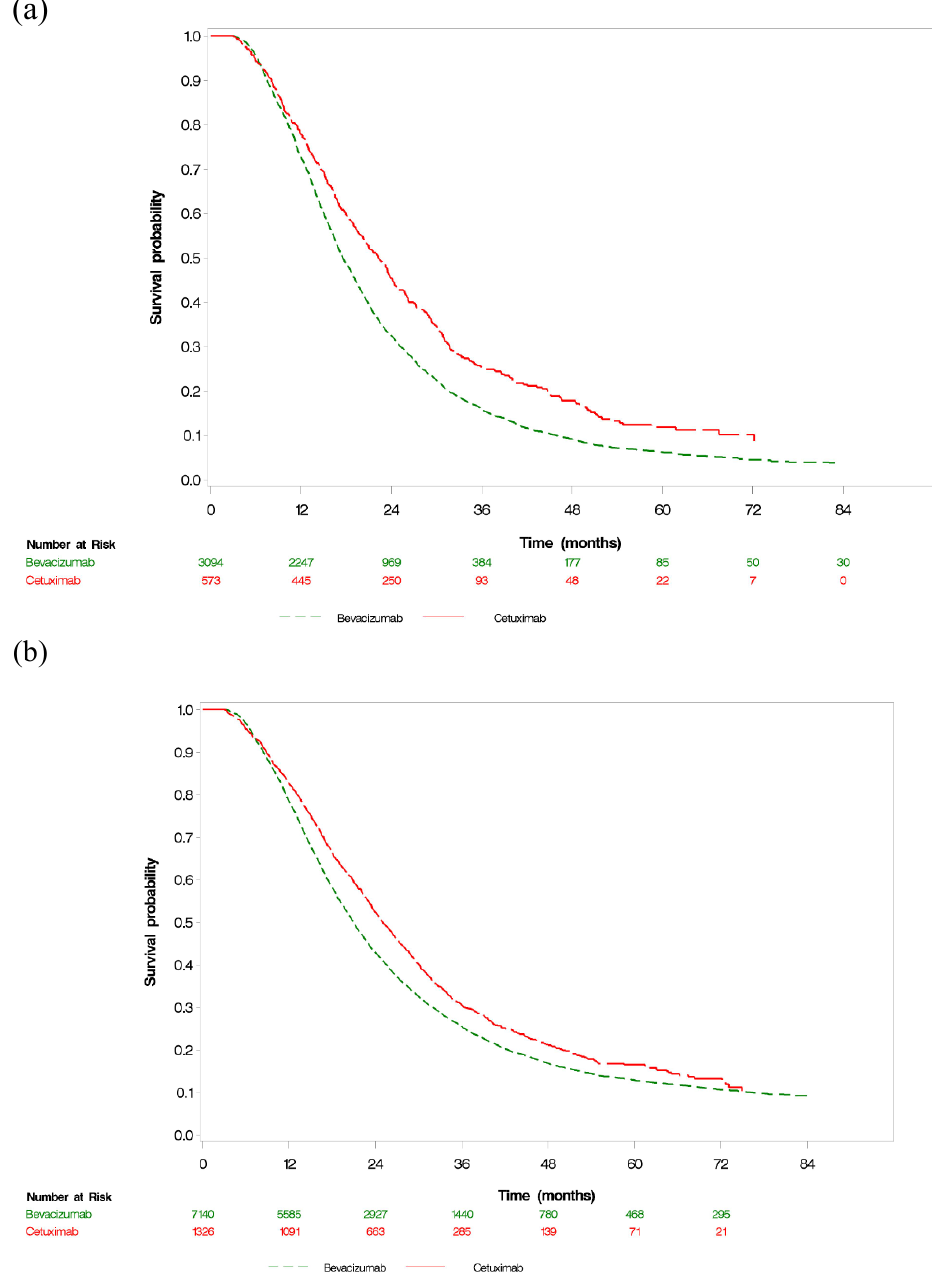
Figure 2. Kaplan–Meier survival curves for OS in mCRC in ( a ) patients without primary tumor resection ( b ) the overall population. mCRC, metastatic colorectal cancer; OS, overall survival.